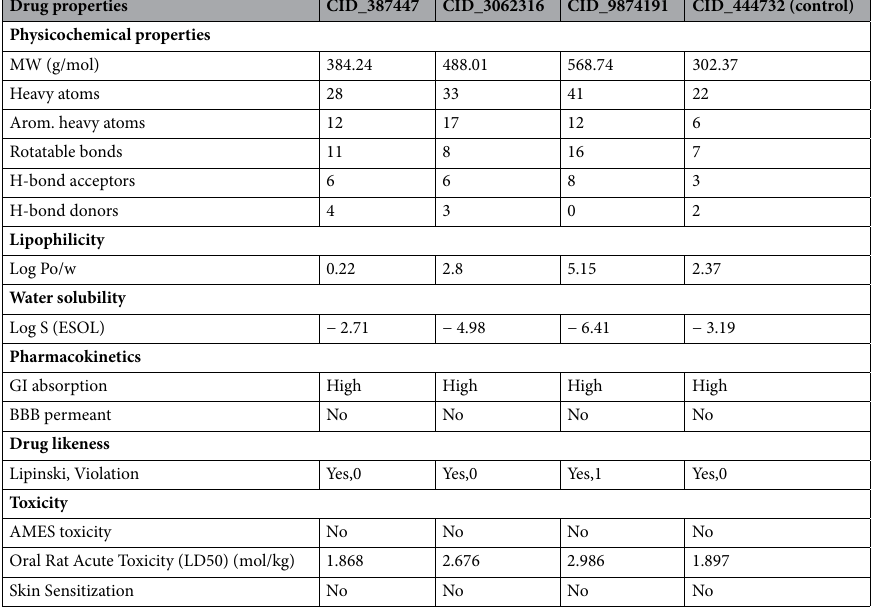
Table 2. Molecular features of the selected chemical